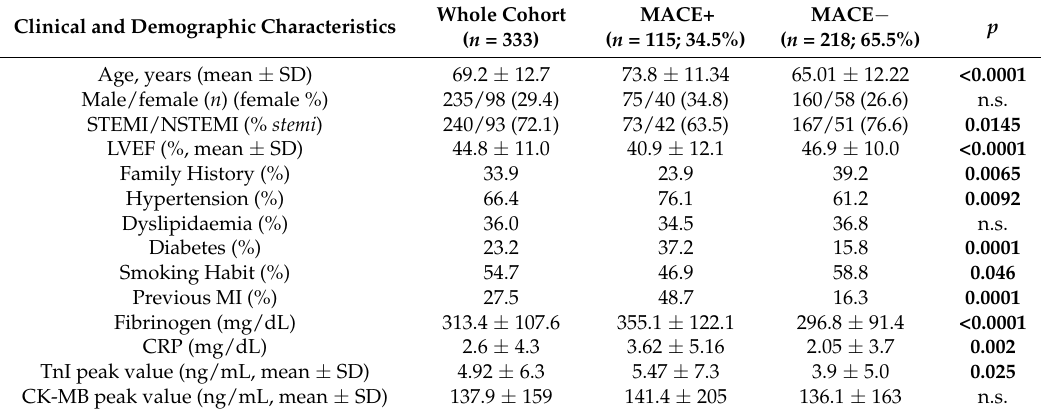
Table 1. Baseline characteristics of patients with (MACE+) and without (MACE − ) major adverse cardiovascular